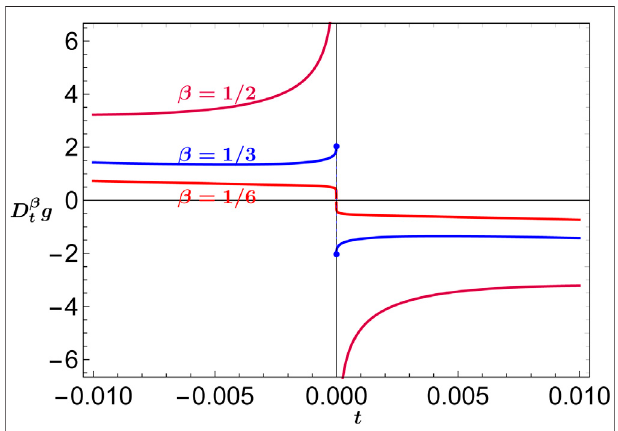
FIGURE 2 | The behaviors of fractional derivatives D β t g for ß equal to 1/2 (purple line), 1/6 (red line), and 1/3 (blue line) near the critical point of Kerr-AdS black hole, with J (cid:2)